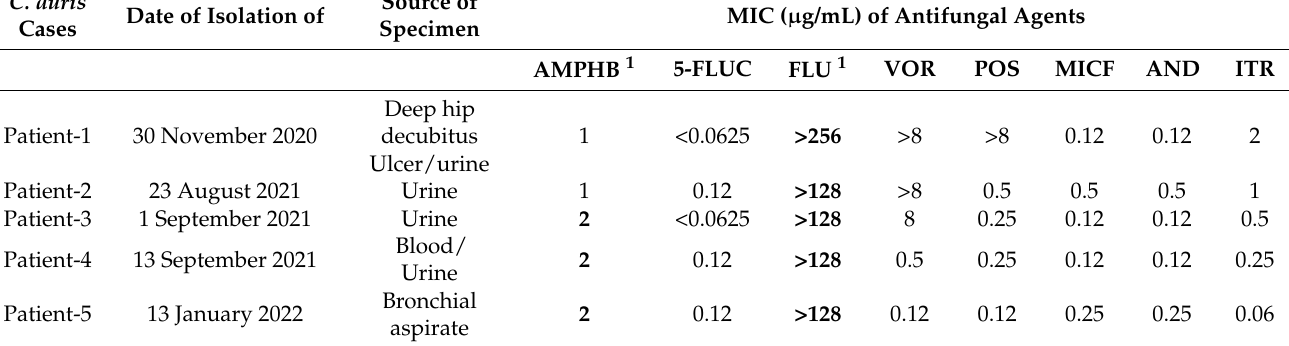
Table 2. Antifungal susceptibility of C. auris clinical isolates.